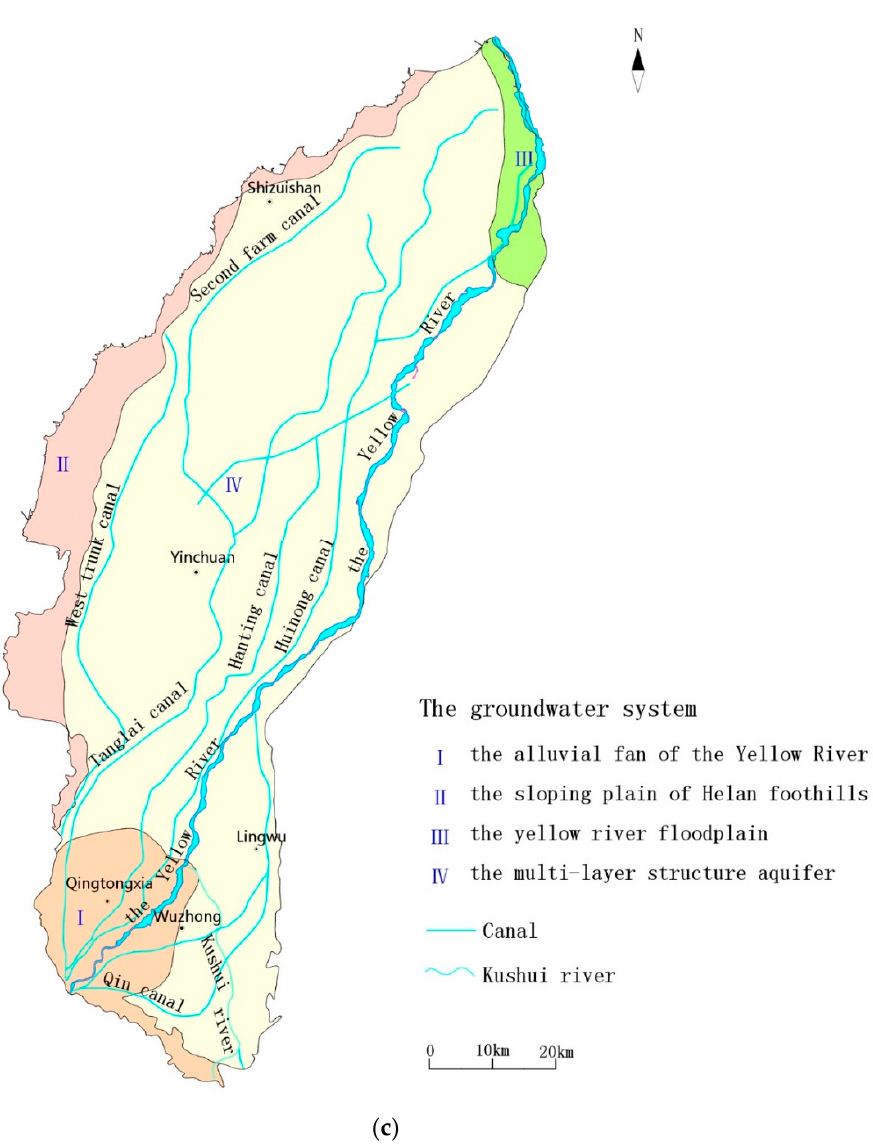
Figure 2. ( a ). The sample points of D and 18 O in study area. ( b ). The spatial distribution of water level monitoring point. ( c ). The spatial distribution of river system.